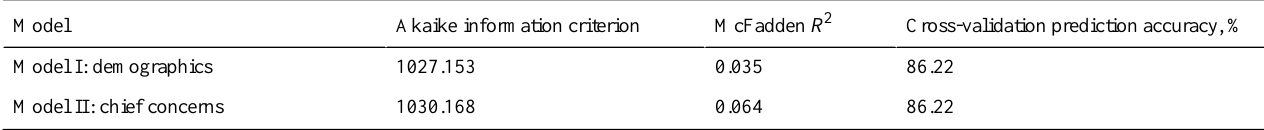
Table 4. Evaluation metrics of multinomial logistic regression models.